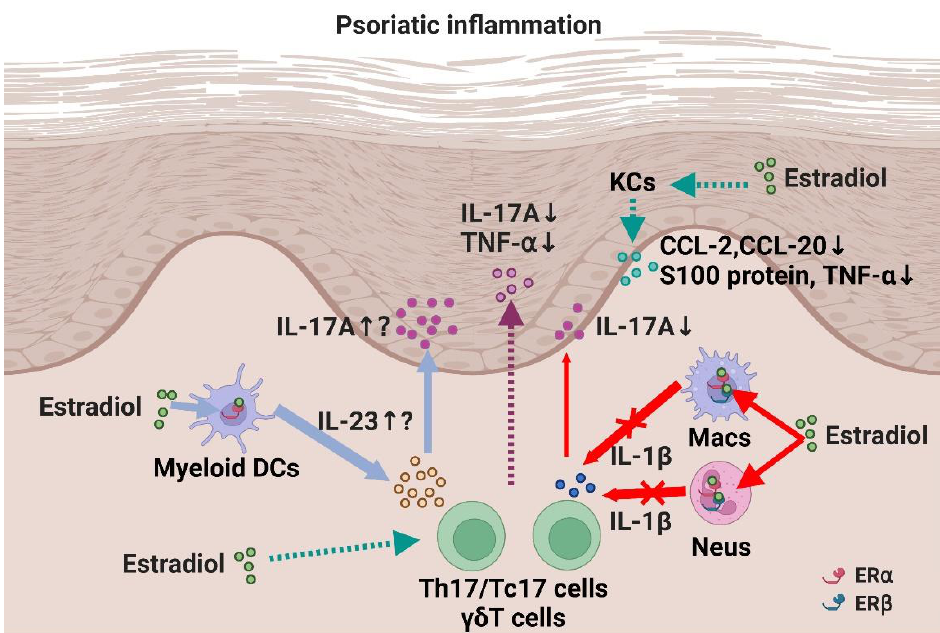
Figure 2. A scheme of possible functions and the mechanisms of estrogen in psoriatic inflammation. E2 play anti-psoriatic functions by downregulating IL-1 β production from neutrophils (Neus) and monocytes/macrophages (Macs) through ER α and ER β . However, in a certain condition, E2 may play facilitating role on psoriatic inflammation by inducing IL-23 production from dendritic cells (DCs) through ER α . Solid lines show the findings from in vivo studies and dotted lines show the findings from in vitro or other disease model studies. Created with